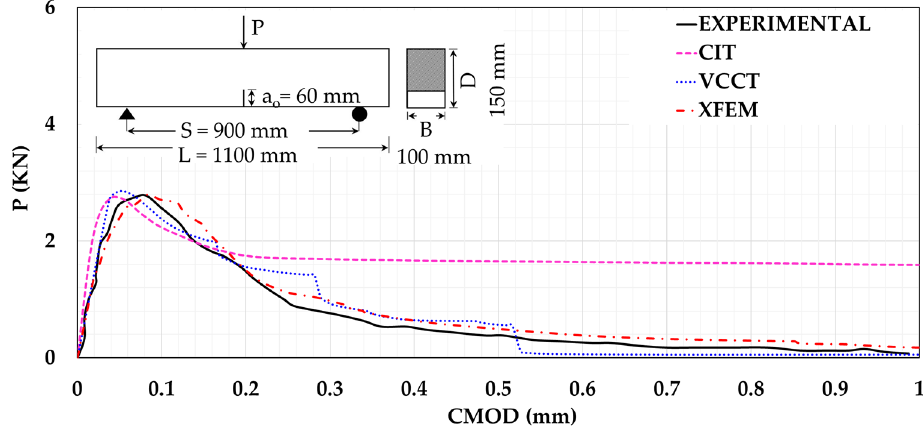
Figure 3. Loading level (P) versus crack mouth opening displacement (CMOD). Table 2. Results of statistical indicators.